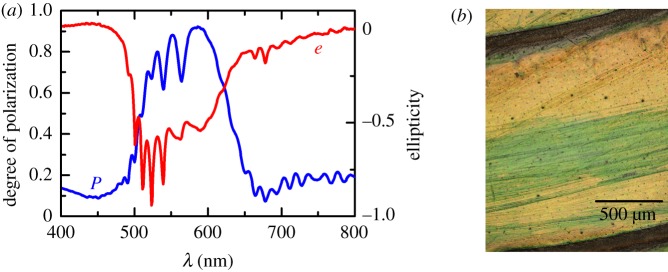
(a) Degree of polarization (P) and ellipticity (e) of light reflected on C. mutabilis for unpolarized incident light at θ = 20°. (b) Optical microscopy image of intact (yellowish) and scratched (green) zones in the cuticle of C. mutabilis.